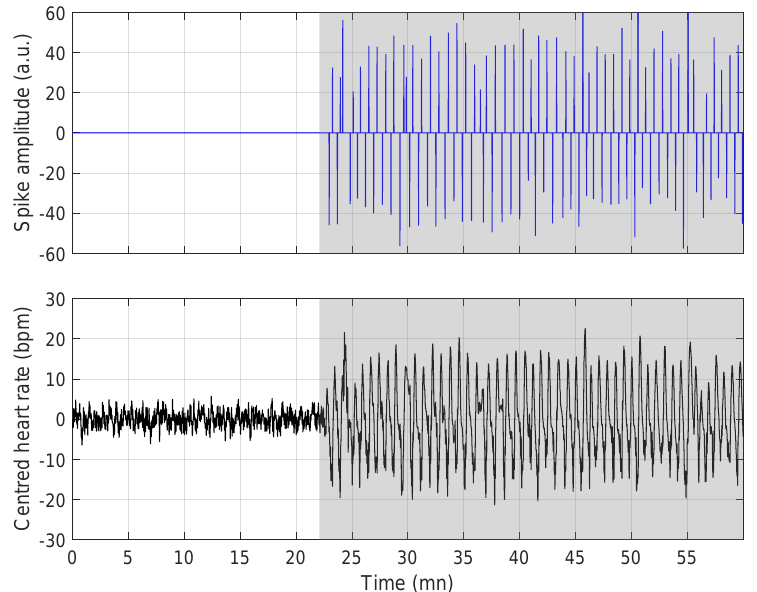
Figure 16. PhysioNet: magnified section of recording “A-03”, extracted from Figure 15. The dif- ference between non-apnoea and apnoea appears clearly and is perfectly captured by the sparse decomposition, while an energy detector should work in such a simple